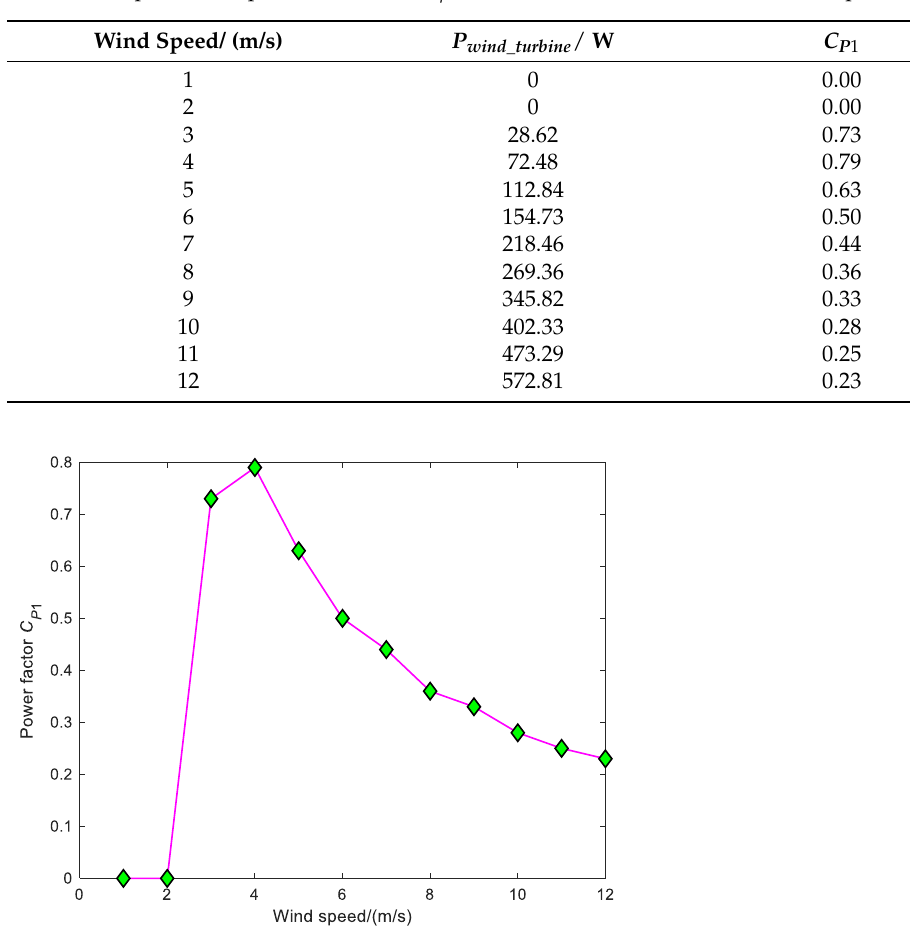
Figure 4. Line graph of